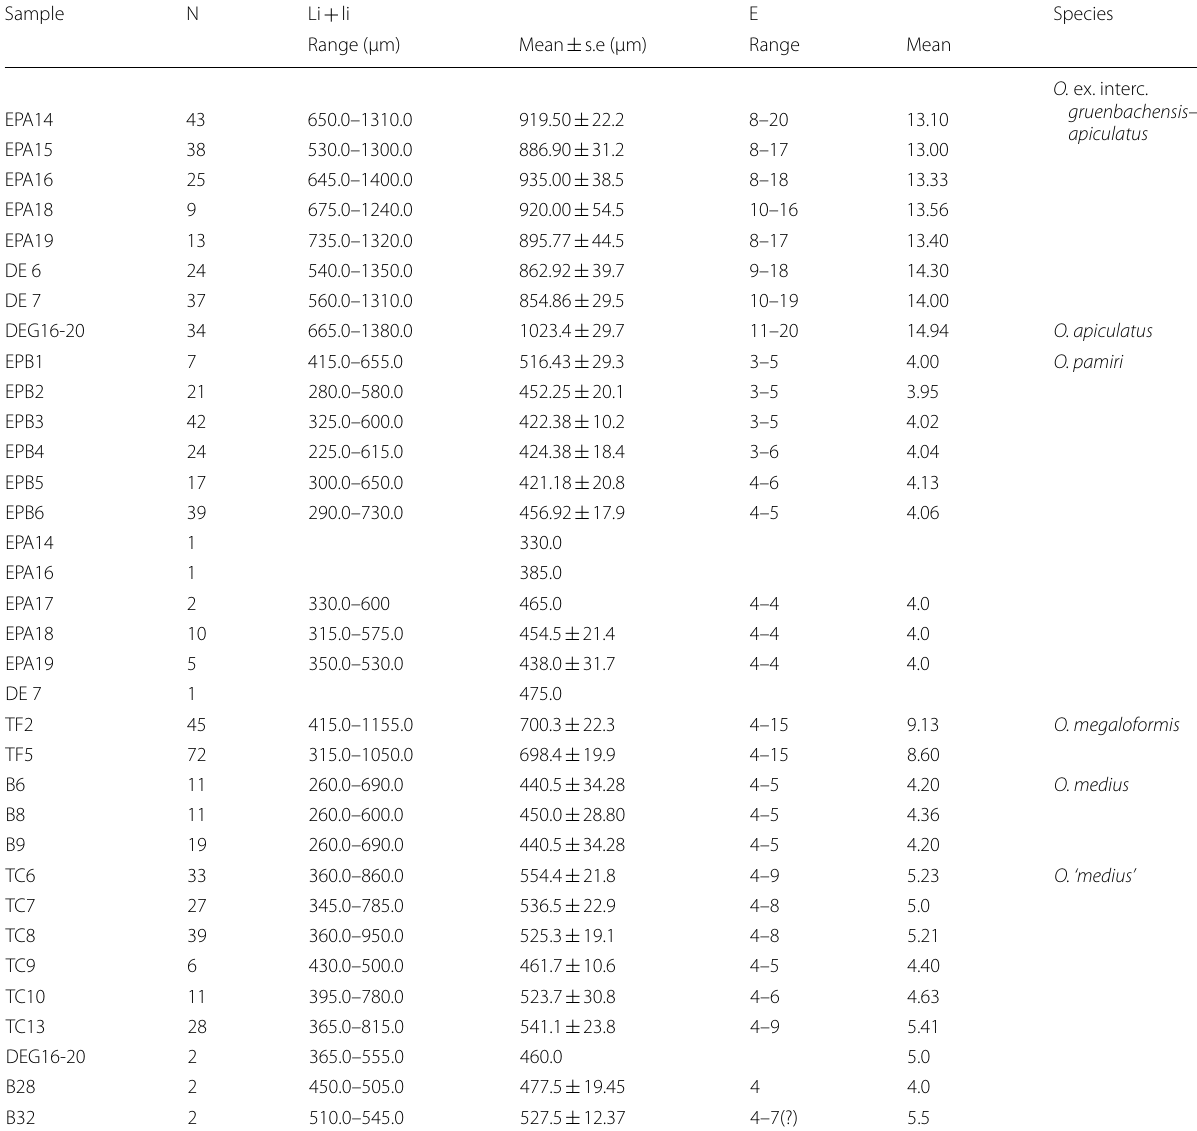
Table 1 Morphometric data of Orbitoides from the Taraklı, Terbüzek, Besni and Germav